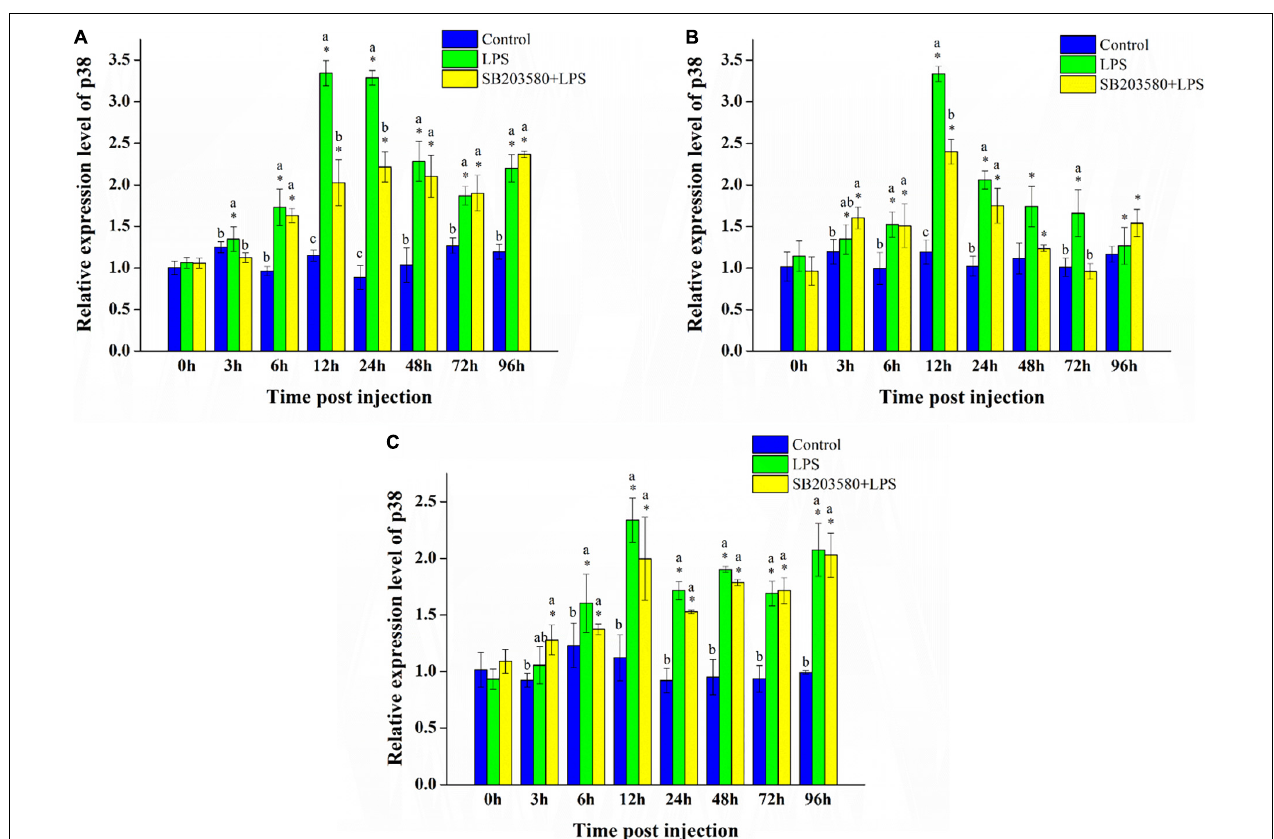
FIGURE 6 | Analysis of the PtP38 gene expression under LPS stimulation. (A) Analysis of the PtP38 gene expression in the hepatopancreas under LPS stimulation. (B) Analysis of the PtP38 gene expression in the gills under LPS stimulation. (C) Analysis of the PtP38 gene expression in the muscle under LPS stimulation. Using GAPDH as an internal reference, the relative expression level of PtP38 in the control group at 0 h was set to 1. Error bars represent the SD of three independent repeats, and the results are expressed as means ± standard deviation. Independent sample t -test was used to analyze the significant changes at different time points in the same treatment group. *Indicates a significant difference between this time point with 0 h. Duncan’s multiple comparison test analyzed the significant changes between different treatments at the same time point. a, b, and c indicate significant differences between treatment groups. P < 0.05 was considered statistically